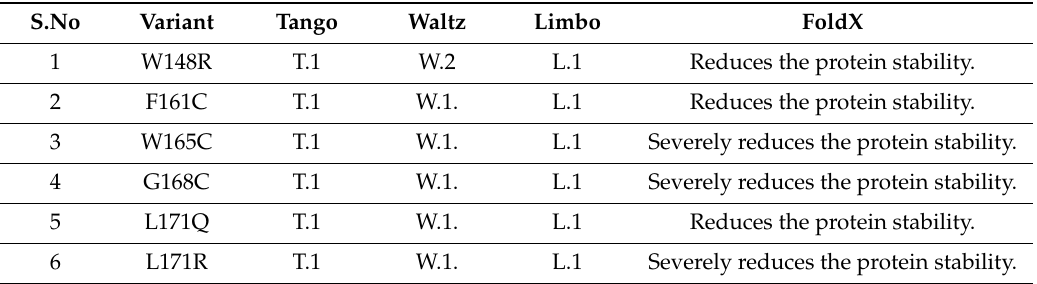
Table 3. Structural and functional impact of FLNB variant using the HOPE server. S.No